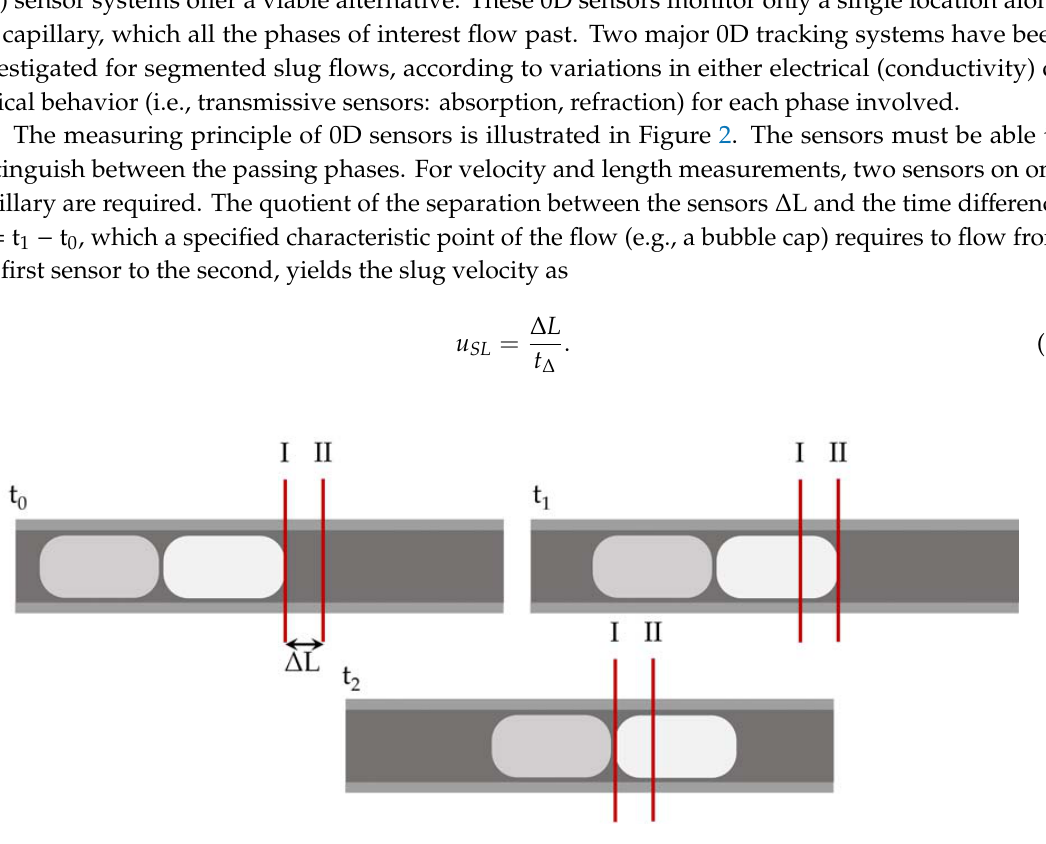
Figure 2. Principle of a zero ‐ dimensional (0D) segment length and velocity sensor. In this case, the length and velocity of the first white bubble is measured. At t 0 , the front cap of the bubble passes by the first sensor I. At t 1 , the same feature passes sensor II. At time t 2 , the rear cap of the bubble passes the sensor I. With the help of the time differences, the velocity and bubble length of this bubble can be calculated using the equations given.